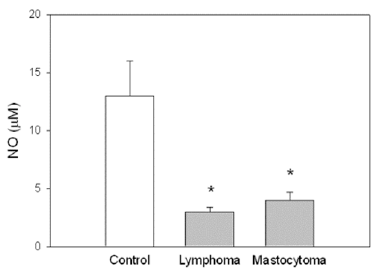
Figure 2. Nitric oxide (NO) levels expressed as µM. Healthy dogs (control, n = 24), multicentric lymphoma (lymphoma, n = 11), primary cutaneous MCT (mastocytoma, n = 14). * p < 0.05 vs. control.